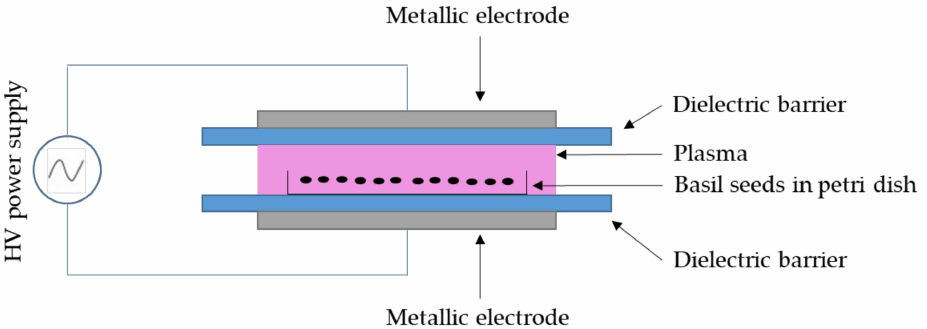
Figure 10. A schematic representation of the experimental set-up of the dielectric barrier discharges (DBD) plasma reactor for plasma treatment of basil